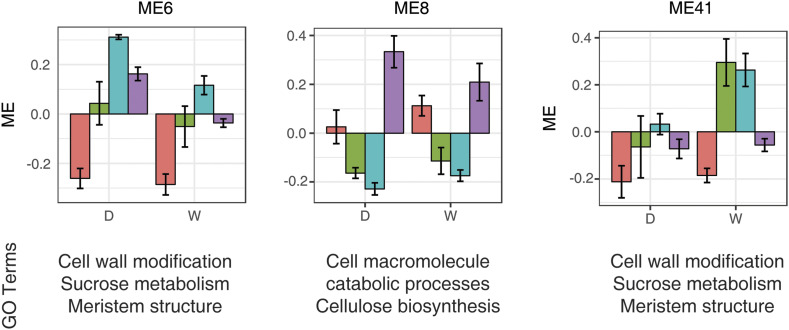
Module eigengene expression of select modules from the homoeologous fiber network. For each module, the barplot presents the module eigengene expression levels centered by means across developmental timepoints for wild and domesticated fiber. Error bars represent the standard errors among three accessions for each genome group at each developmental stage. Developmental stages: red,5 dpa; green, 10 dpa; blue, 15 dpa; purple, 20 dpa.